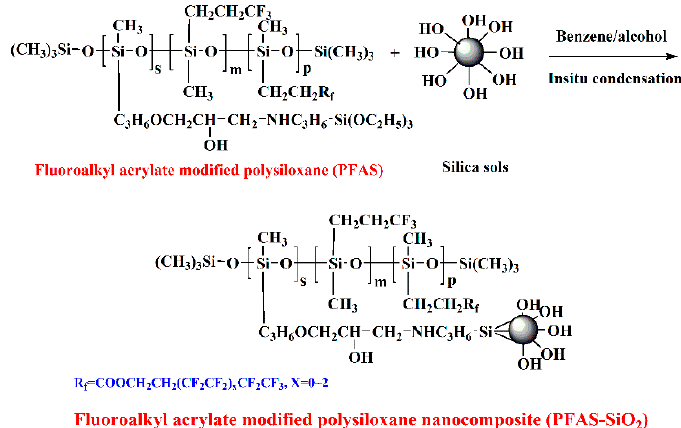
Figure 1. Schematic diagram of the synthesis of PFAS-SiO 2.